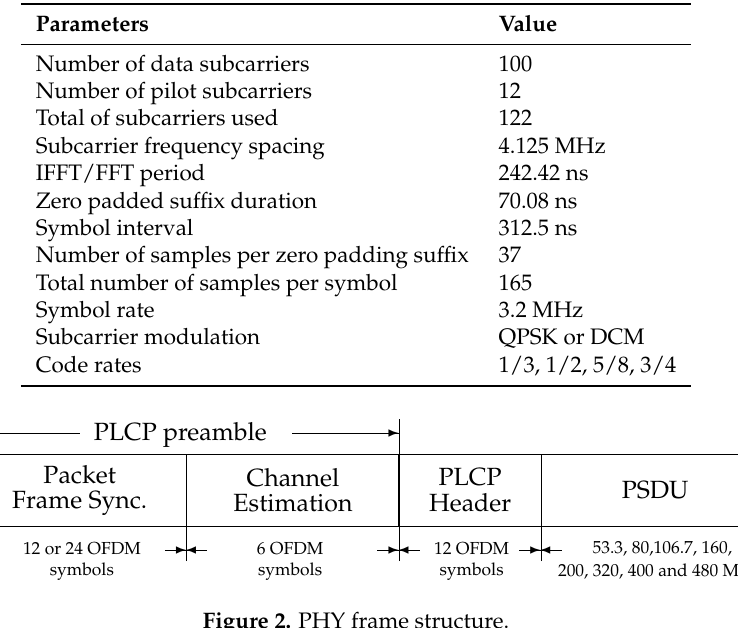
Table 1. OFDM parameters for the ECMA-368 standard.